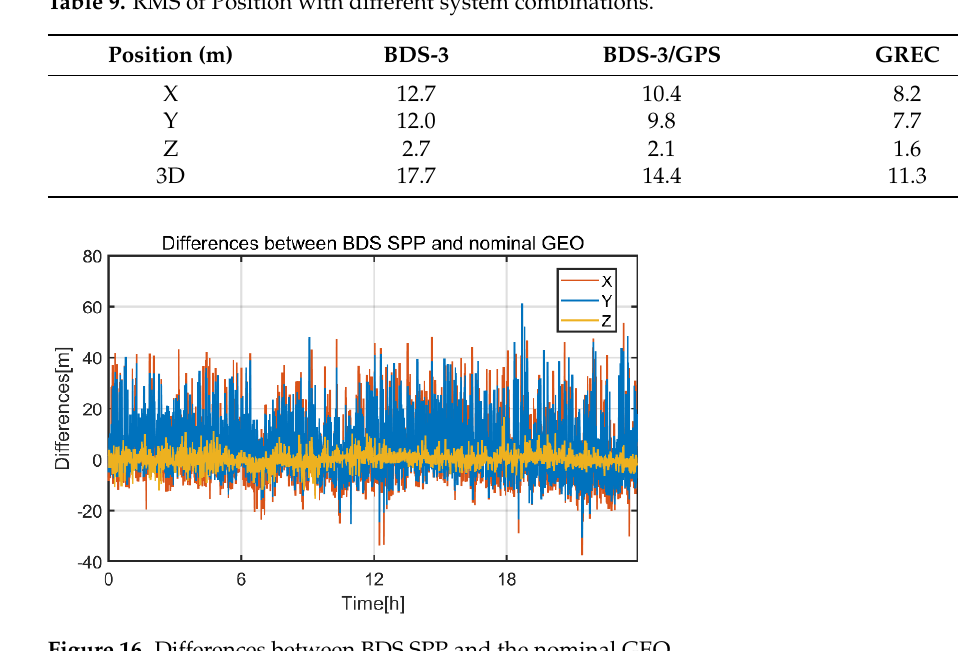
Table 8. Satellite visibility of different system combinations.